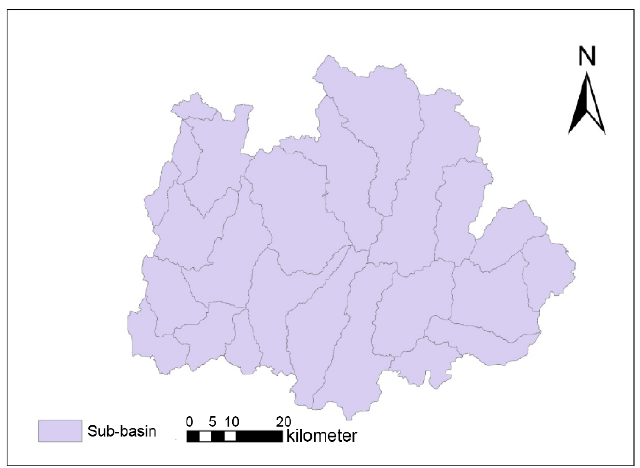
Figure 5. Sub-basin partitioning of Qixia.